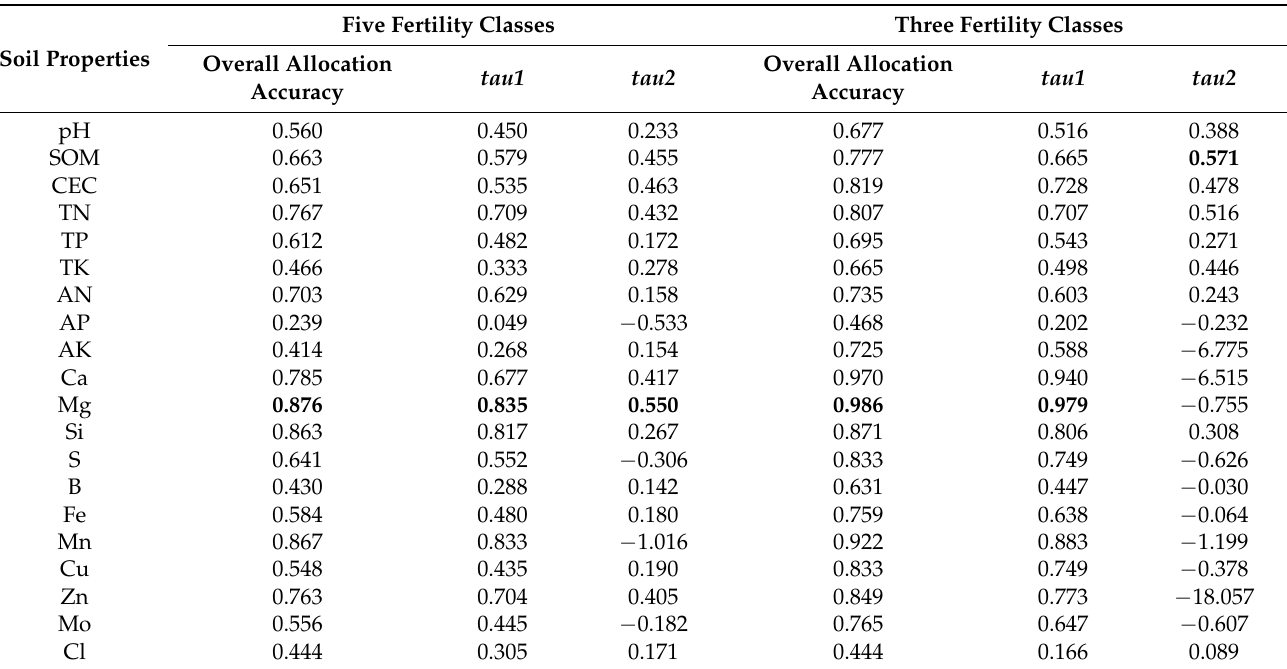
Table 10. Comparison of the allocation accuracy for five fertility classes versus three fertility